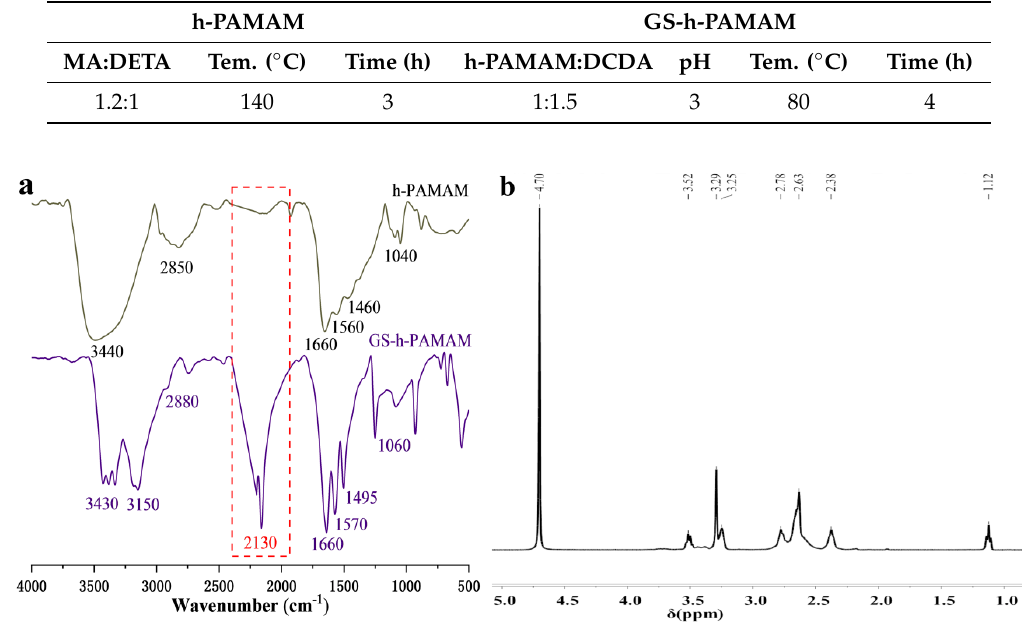
Table 2. The optimal synthesis conditions for h-PAMAM and GS-h-PAMAM.